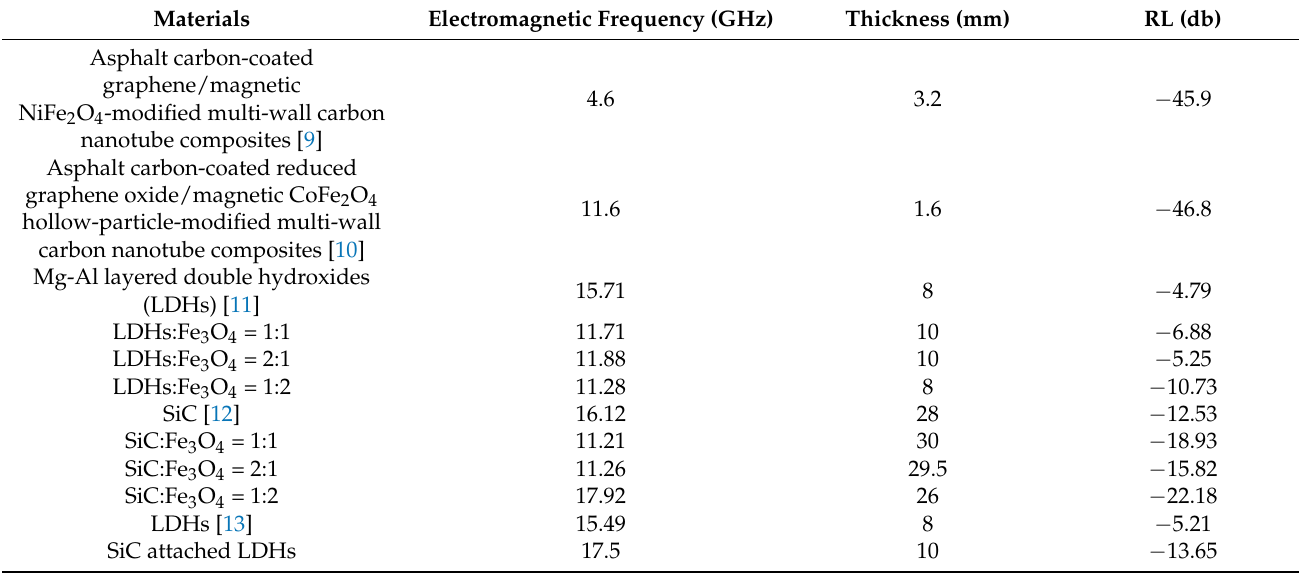
Table 1. The reflection loss values of representative